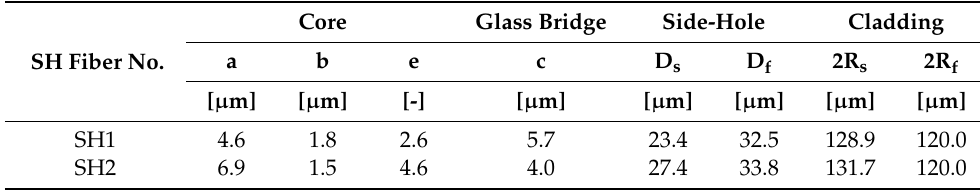
Table 1. Geometrical parameters of SH fibers.